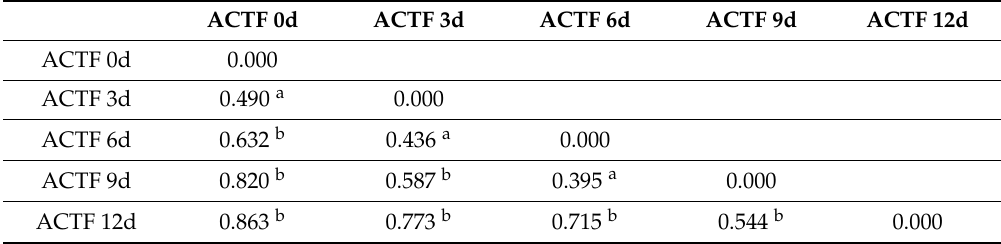
Table 5. Correlation matrix among the carrageenan coated trout fillets plus essential lemon oil (ACTF). The numbers indicate the discrimination